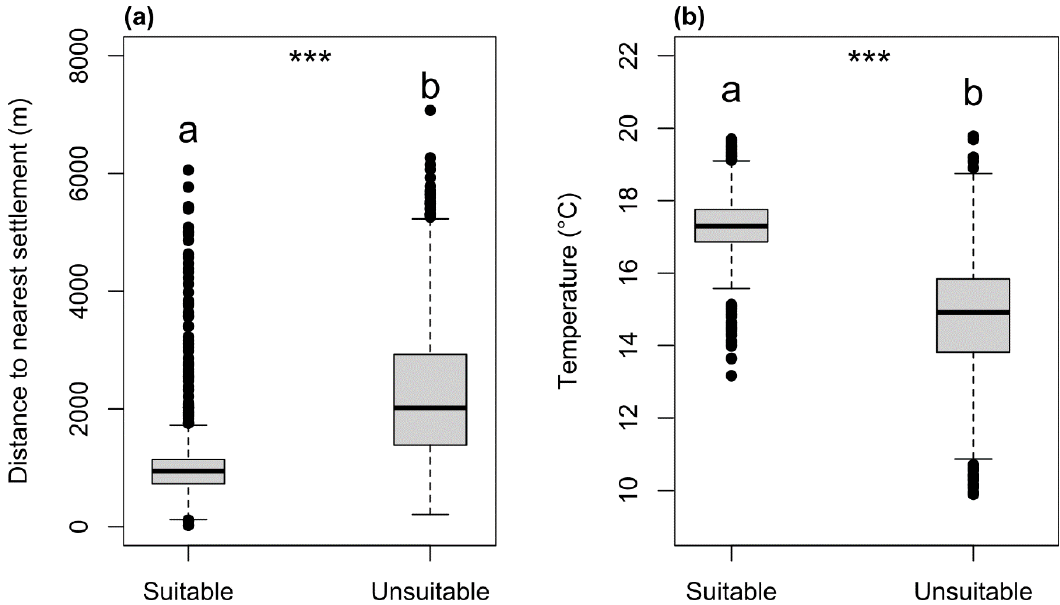
Figure 4. ( a ) Pixels that were modeled as suitable habitat for P. setaceum show smaller distances to the nearest settlement compared to pixels without P. setaceum . ( b ) Average mean annual temperatures of pixels with P. setaceum presence are considerably higher compared to pixels where the species is absent. Highly significant results are indicated by three asterisks.